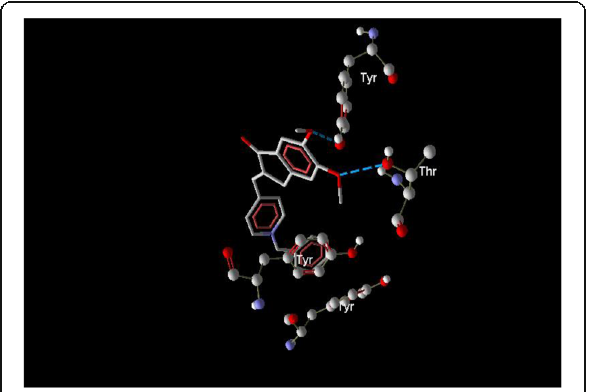
Fig. 6 Hydrophobic interaction of donepezil in the active site of AChE